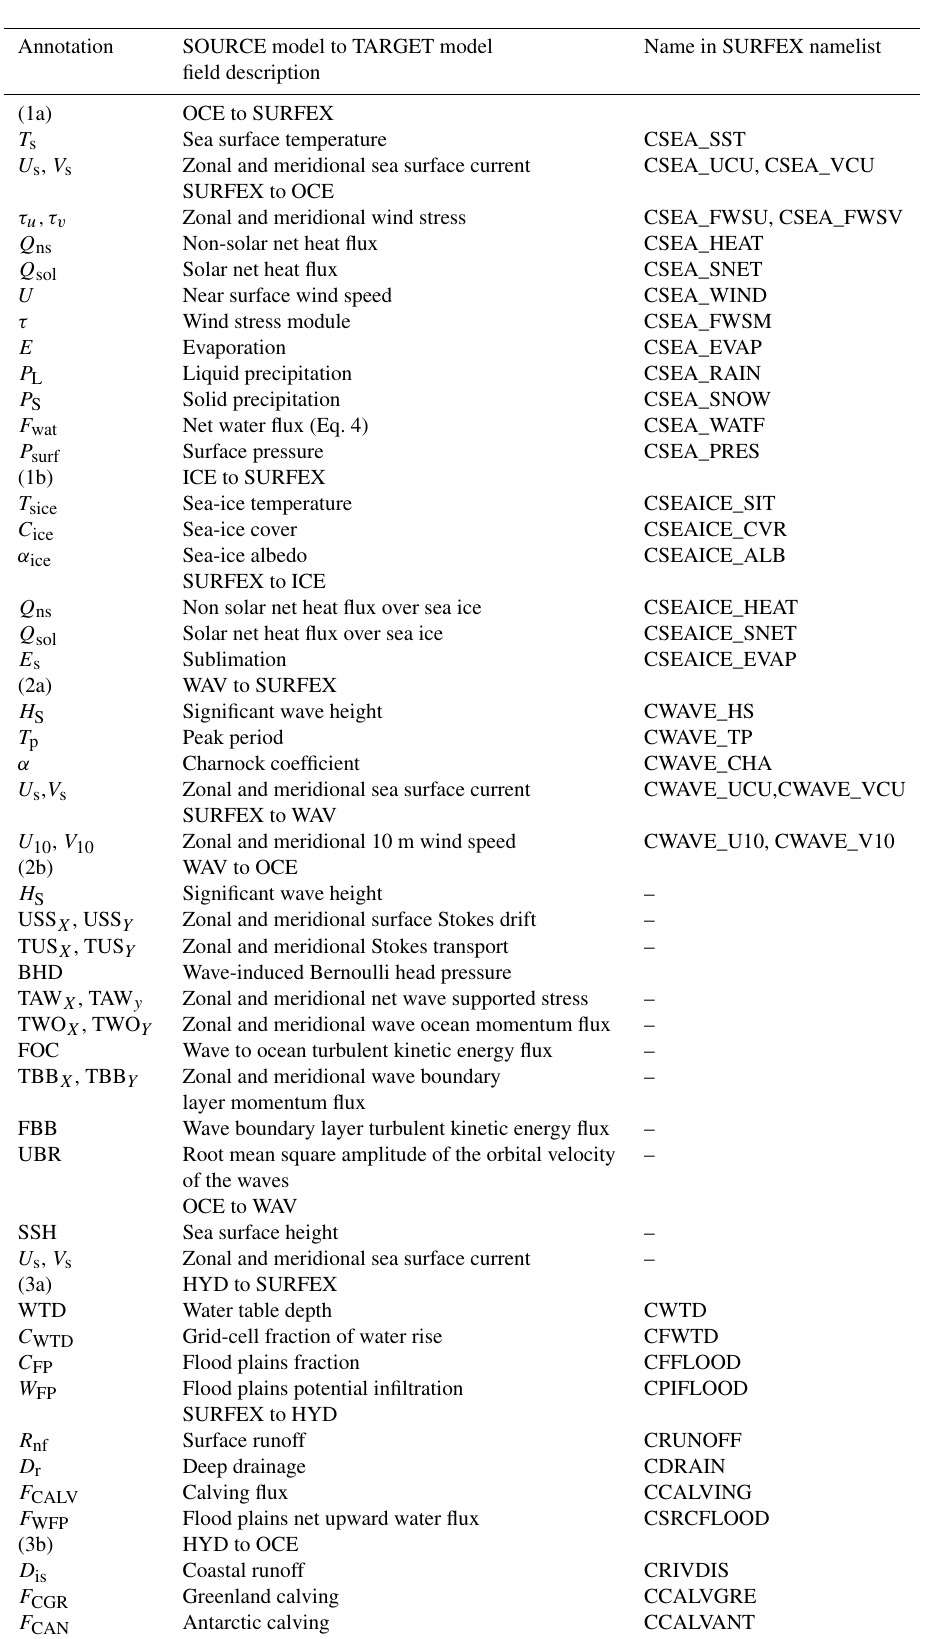
Table 1. List of exchanged fields (see flow chart in Fig. 1).